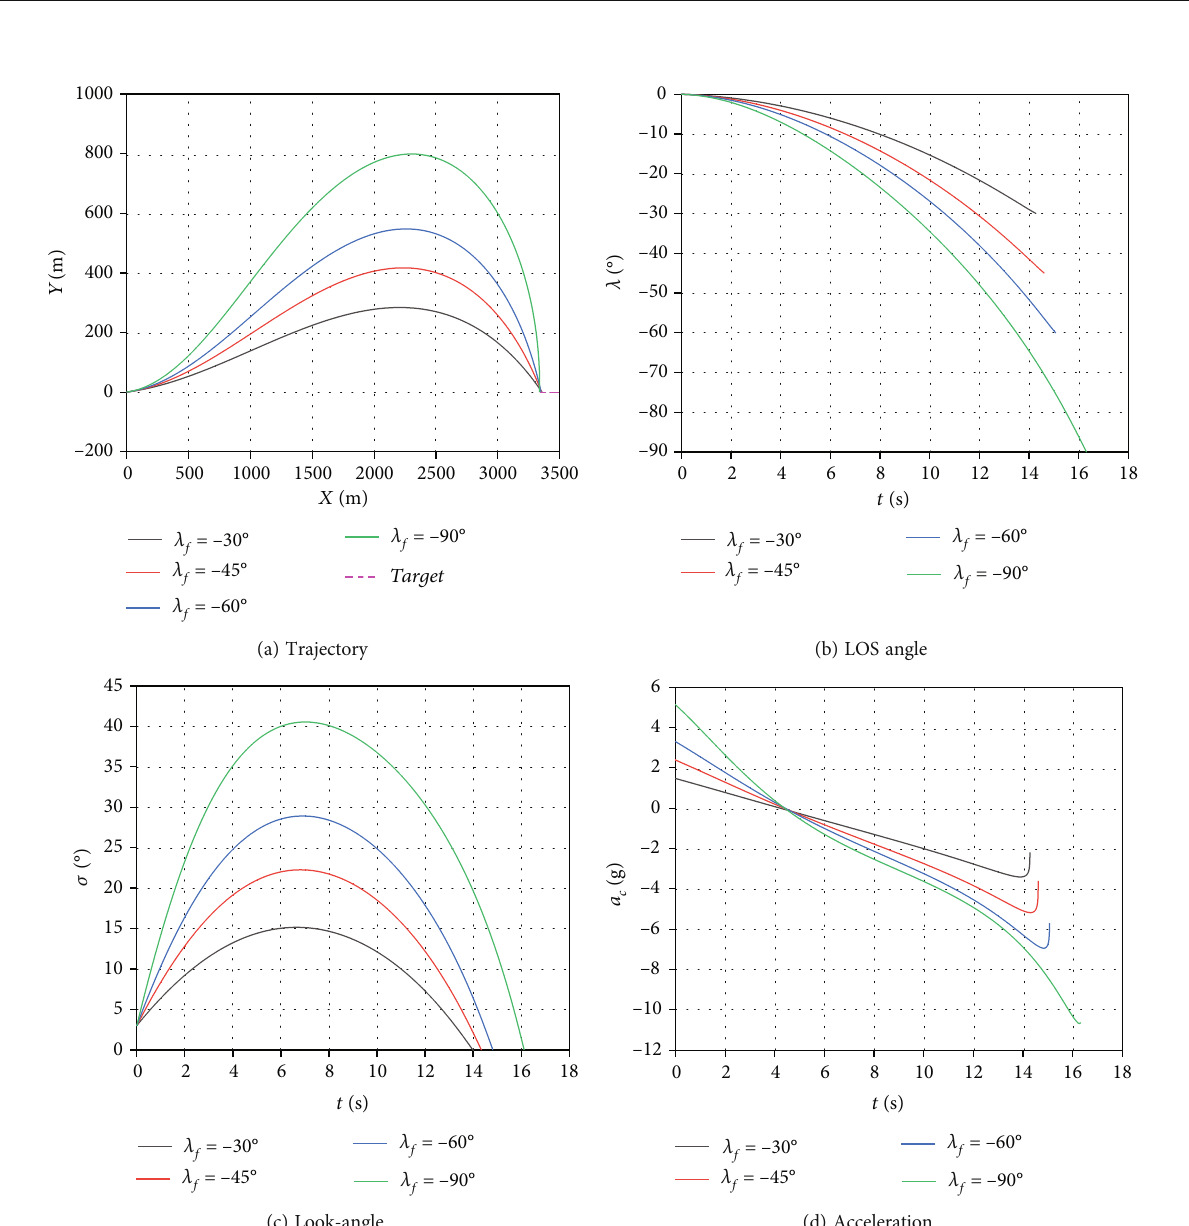
Figure 3: The results of di ff erent impact angles without FOV constraints.